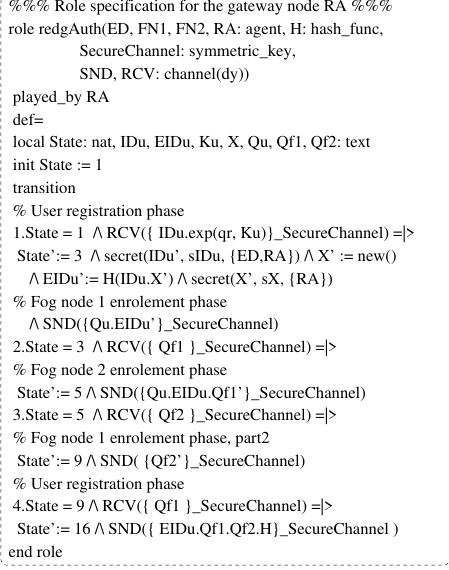
Figure 9. HLPSL role specification for the gateway node ( RA ) .